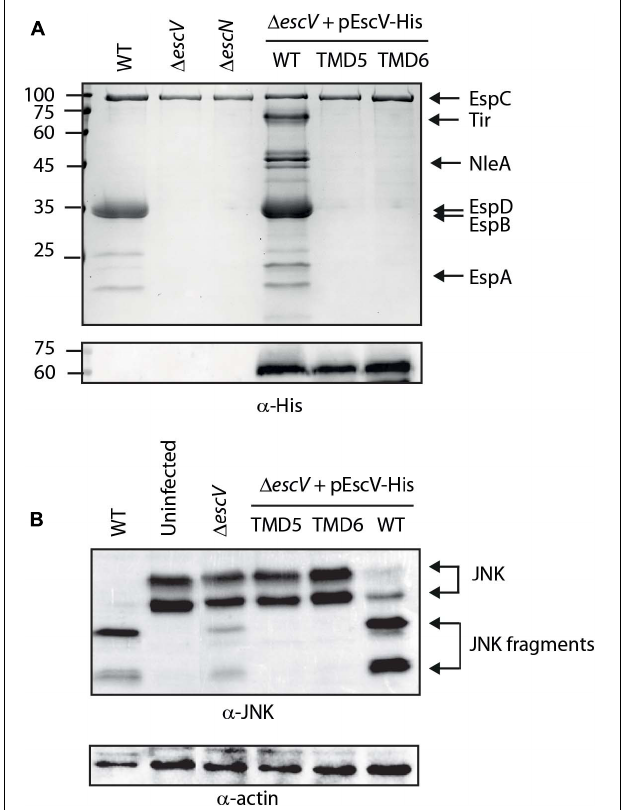
FIGURE 4 | Replacement of EscV TMD5 and TMD6 by an alternative hydrophobic sequence abolishes T3SS activity. (A) Protein secretion profiles of EPEC WT, (cid:49) escV , (cid:49) escN and EPEC (cid:49) escV strain carrying the pEscV wt -His, pEscV-TMD5 ex -His, or pEscV-TMD6 ex -His plasmids grown under T3SS-inducing conditions with 0.1 mM IPTG. The secreted fractions were filtered and protein content was concentrated from the supernatants of bacterial cultures and analyzed by SDS-PAGE and Coomassie blue staining. The T3SS-secreted translocators and effectors EspA, EspB, EspD, NleA, and Tir are marked on the right of the gel. EspC, which is not secreted via the T3SS, is also indicated. EscV expression was examined by analyzing bacterial pellets by SDS-PAGE and western blot analysis with an anti-His antibody. Numbers on the left are molecular masses in kilodaltons. (B) Proteins extracted from HeLa cells infected with WT, (cid:49) escN , (cid:49) escV , or (cid:49) escV carrying the pEscV wt -His, pEscV-TMD5 ex -His, or pEscS-TMD6 ex -His, were subjected to western blot analysis using anti-JNK antibody and anti-actin (loading control). JNK and its degradation fragments are